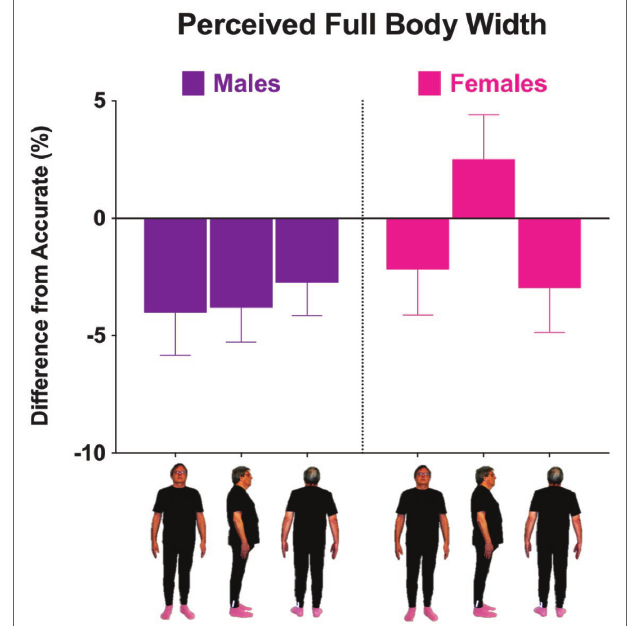
FIGURE 3 | Mean differences from accurate for males ( left panel ) and females ( right panel ) when body width was distorted for each viewpoint. Positive and negative scores represent overestimation and underestimation, respectively. Error bars represent ±1 SEM.